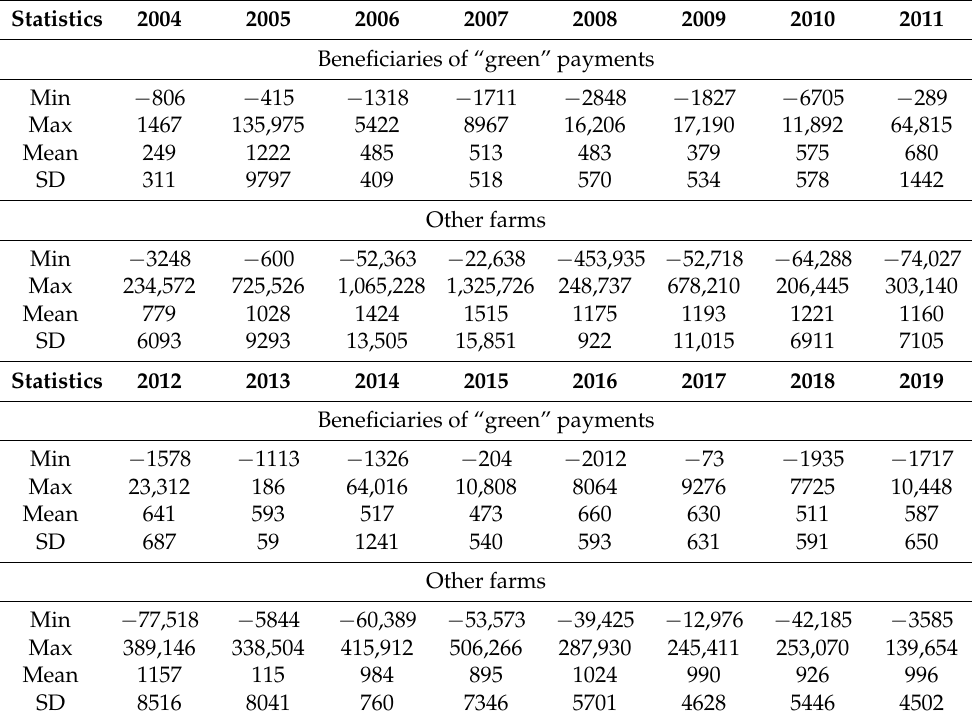
Table 3. Descriptive statistics for family farm income per 1 ha of UAA